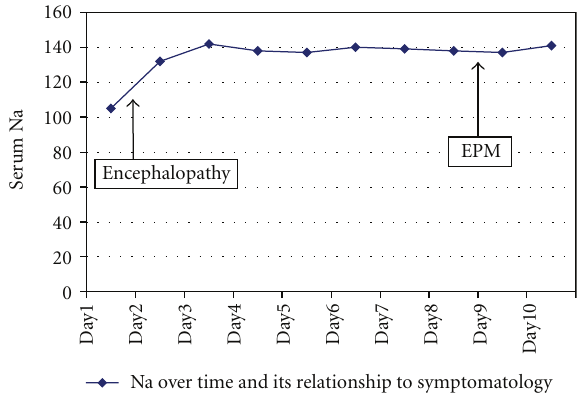
Figure 1: Serum Na by time.